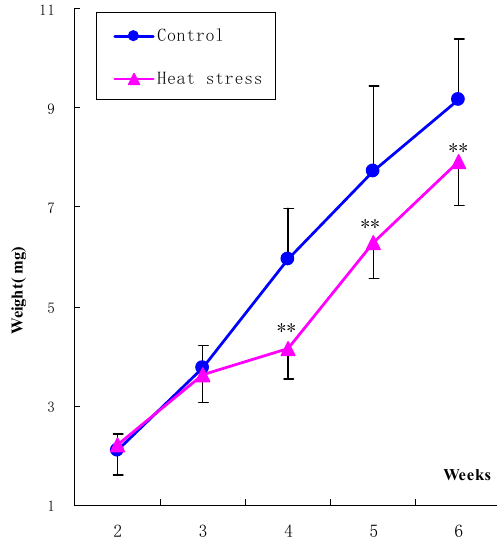
Figure 2. Effects of HS on the weight of pituitary in Wenchang chicks ( n = 6). Note: compared between CK and HS groups at the same age. ∗∗ P < 0 . 01.